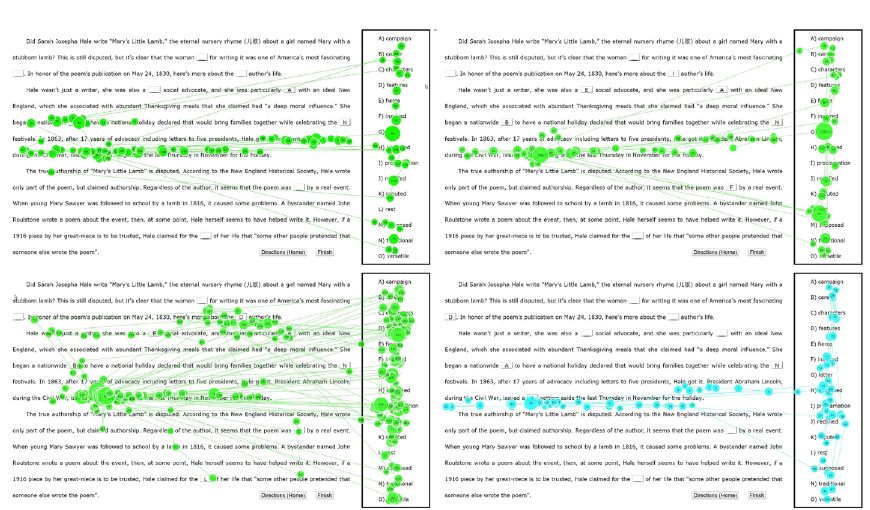
Fig. 4 DX’s three attempts and FF’s single attempt for Blank